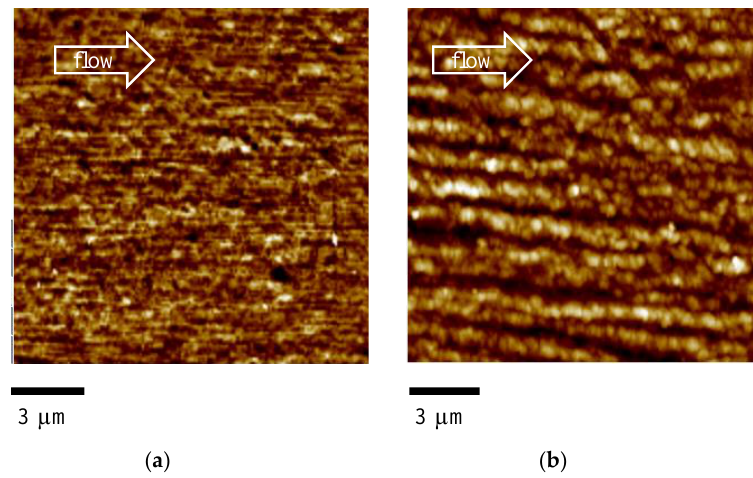
Figure 3. Enlargement of the AFM height map at ( a ) 0.24 mm and ( b ) 0.4 mm distance from the sample surface for the Passive sample.